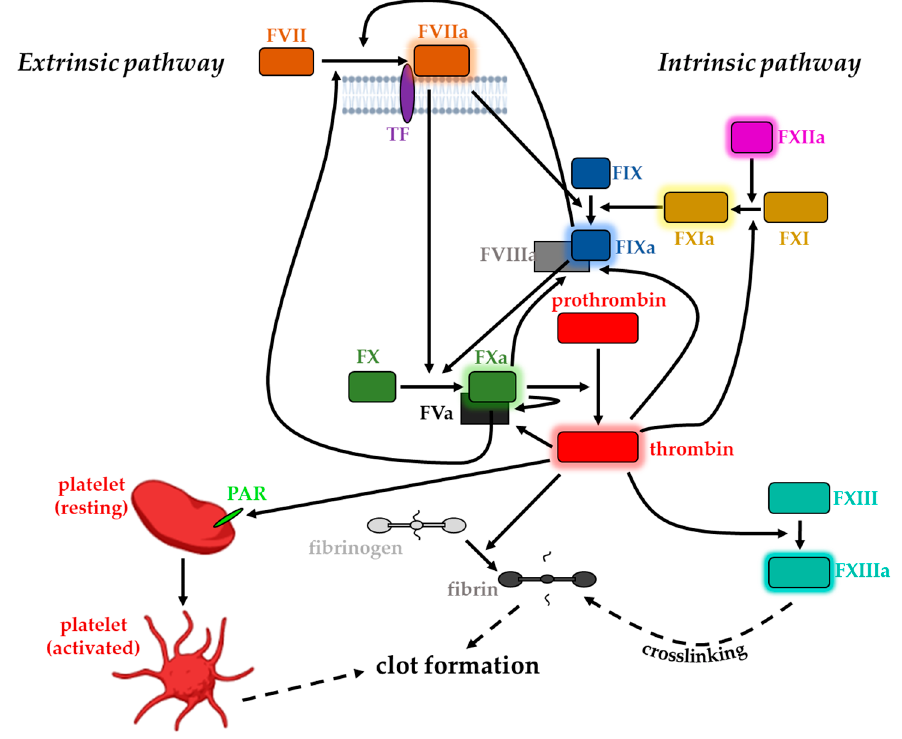
Figure 1. Schematic overview of the coagulation cascade: Extrinsic pathway is initiated by the binding of FVIIa to TF, intrinsic pathway involves activation of FXIa; both pathways finally merge, resulting in thrombin generation which fulfills several functions required for efficient clot formation. Adapted from BioRender.com (accessed on 16 May 2022).